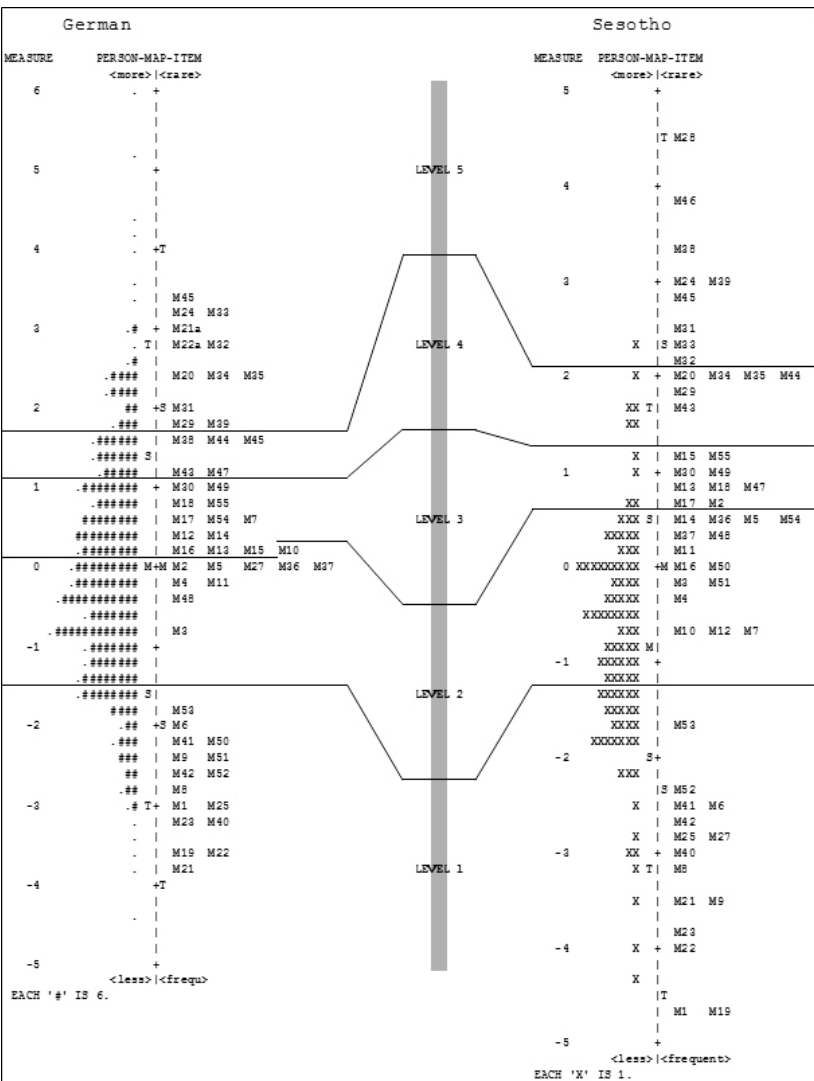
Figure 3: German and Sesotho item-person